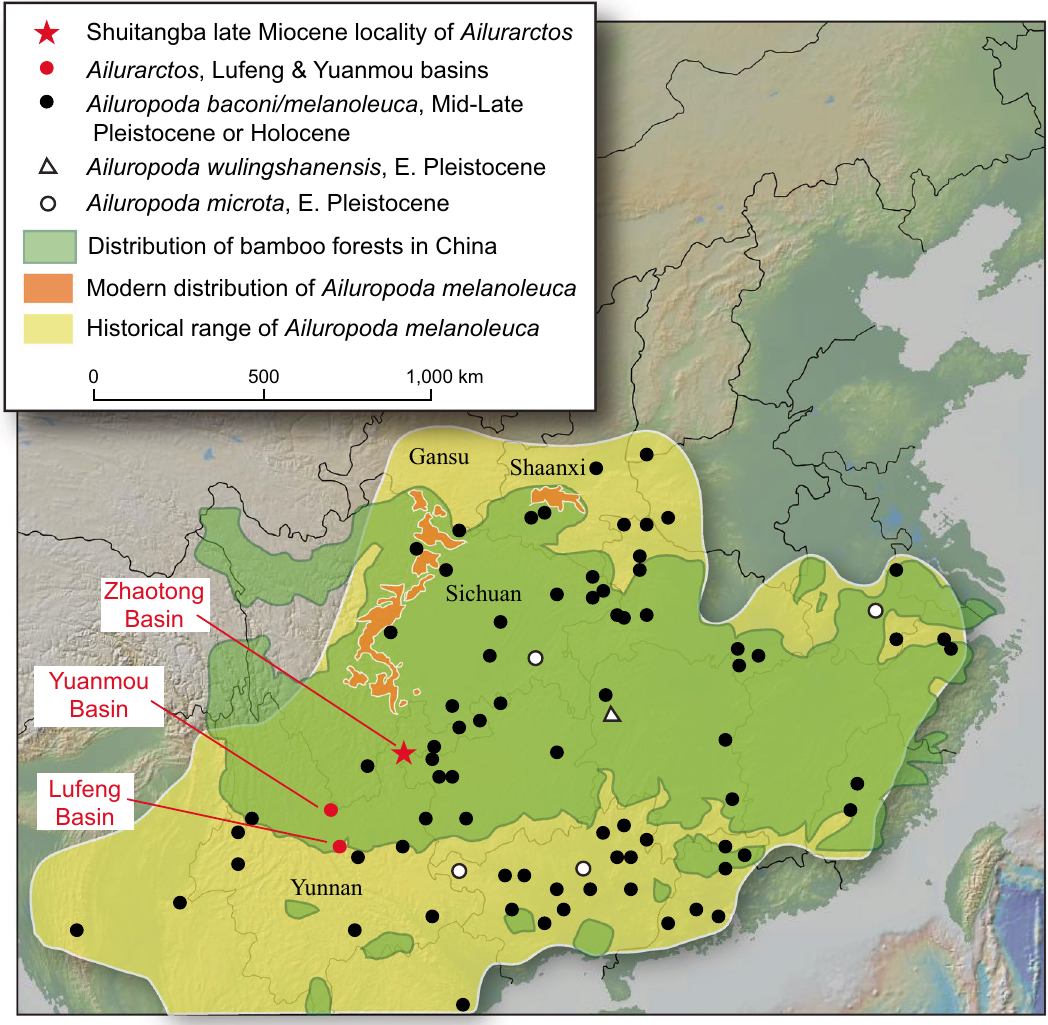
Figure 1. Map of southern China showing late Miocene localities with panda specimens in Yunnan (red symbols), the giant panda’s modern distribution (orange) 16 and historical range (yellow) 16–18 , present approximate bamboo forest distribution in China (green) 19 , and Pleistocene and later fossil distribution (solid and open black circles and triangles) 16,18–24 . We eliminated the humerus record from Zhoukoudian locality 1 following Jiangzuo et al. 25 (see discussion in online Supplementary material). Topographical map generated by GeoMapApp (version 3.6.10) under CC BY license 26